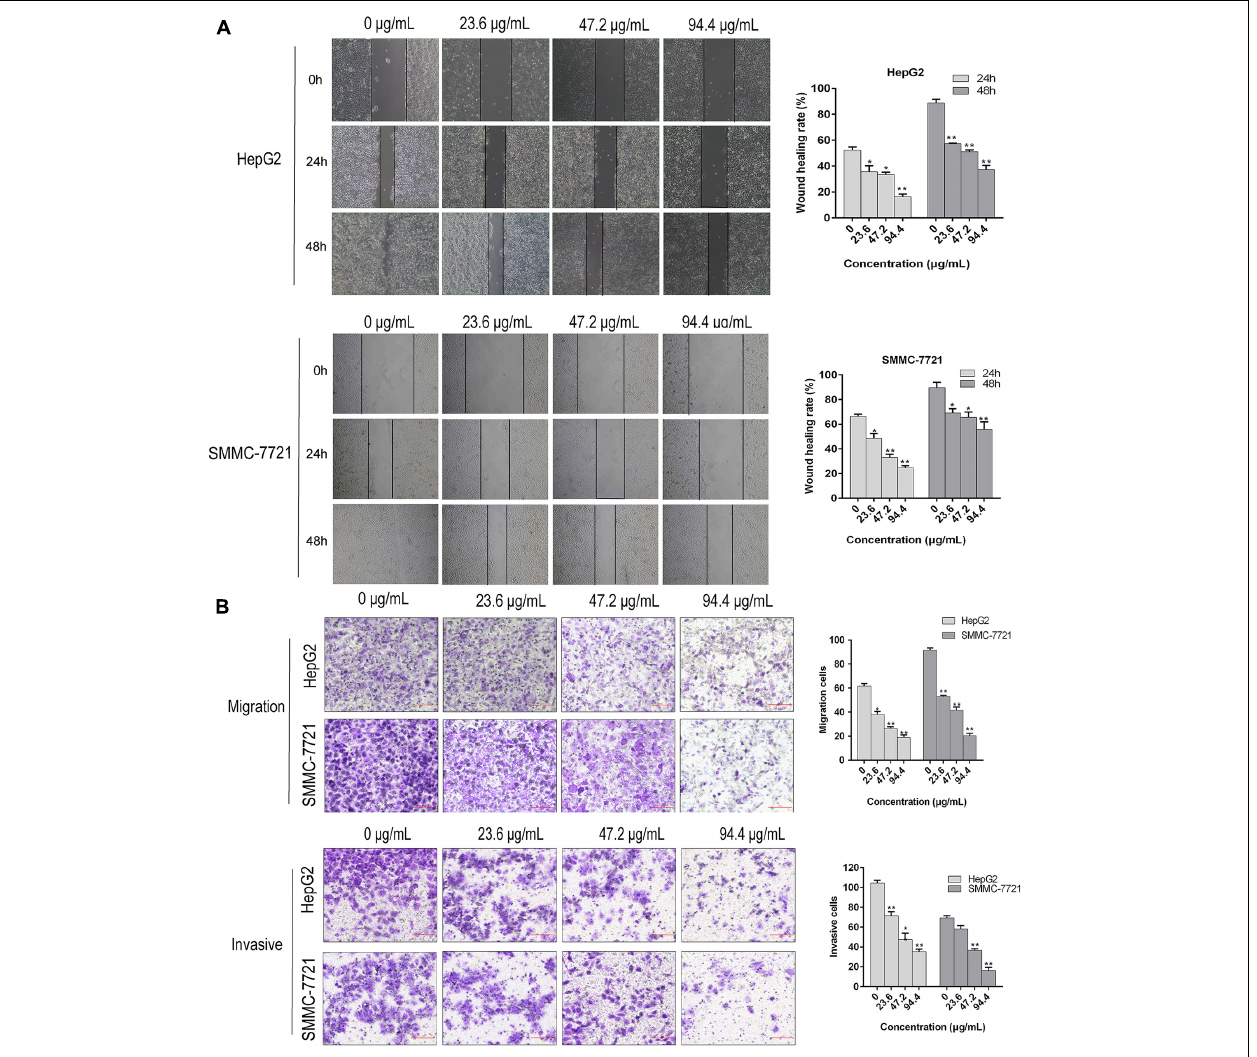
FIGURE 3 | AAEO treatment suppresses the migration and invasion of HCC cells in vitro . (A) Representative images of wound healing assay (left panels) and corresponding wound healing rate (right panels) in SMMC-7721 and HepG2 cells treated with AAEO (23.6, 47.2, and 94.4 µ g/mL). (B) Representative images of transwell migration assay (without matrigel) and invasion assays (with matrigel) in SMMC-7721 and HepG2 cells treated with AAEO for 24 h. Data are expressed as the mean ± SD of three independent experiments. *p < 0.05 and **p < 0.01 vs. the control group.